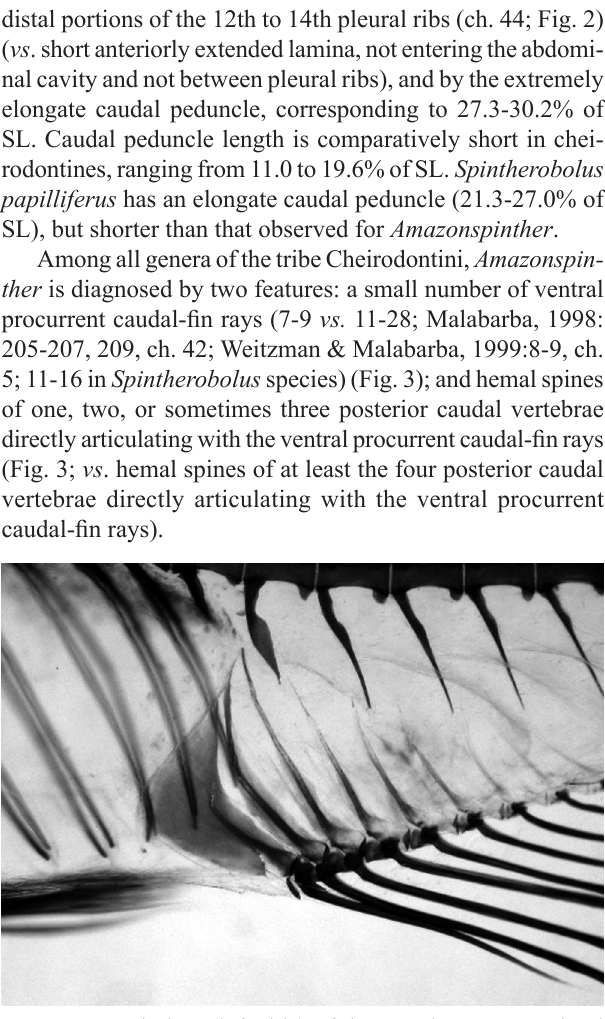
Fig. 2. Lateral view (left side) of the anteriormost proximal radial of the anal fin of Amazonspinther dalmata , showing the anteriorly extended lamina entering the abdominal cavity (MCP 37572, 14.98 mm SL, c&s).